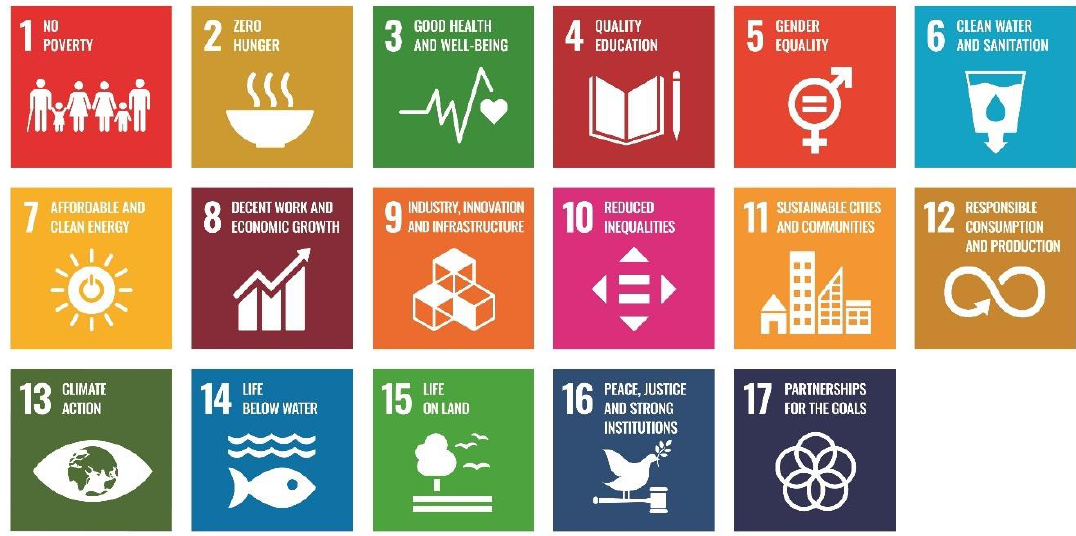
Figure 1. The 17 sustainability goals of the UN; image section from [36].